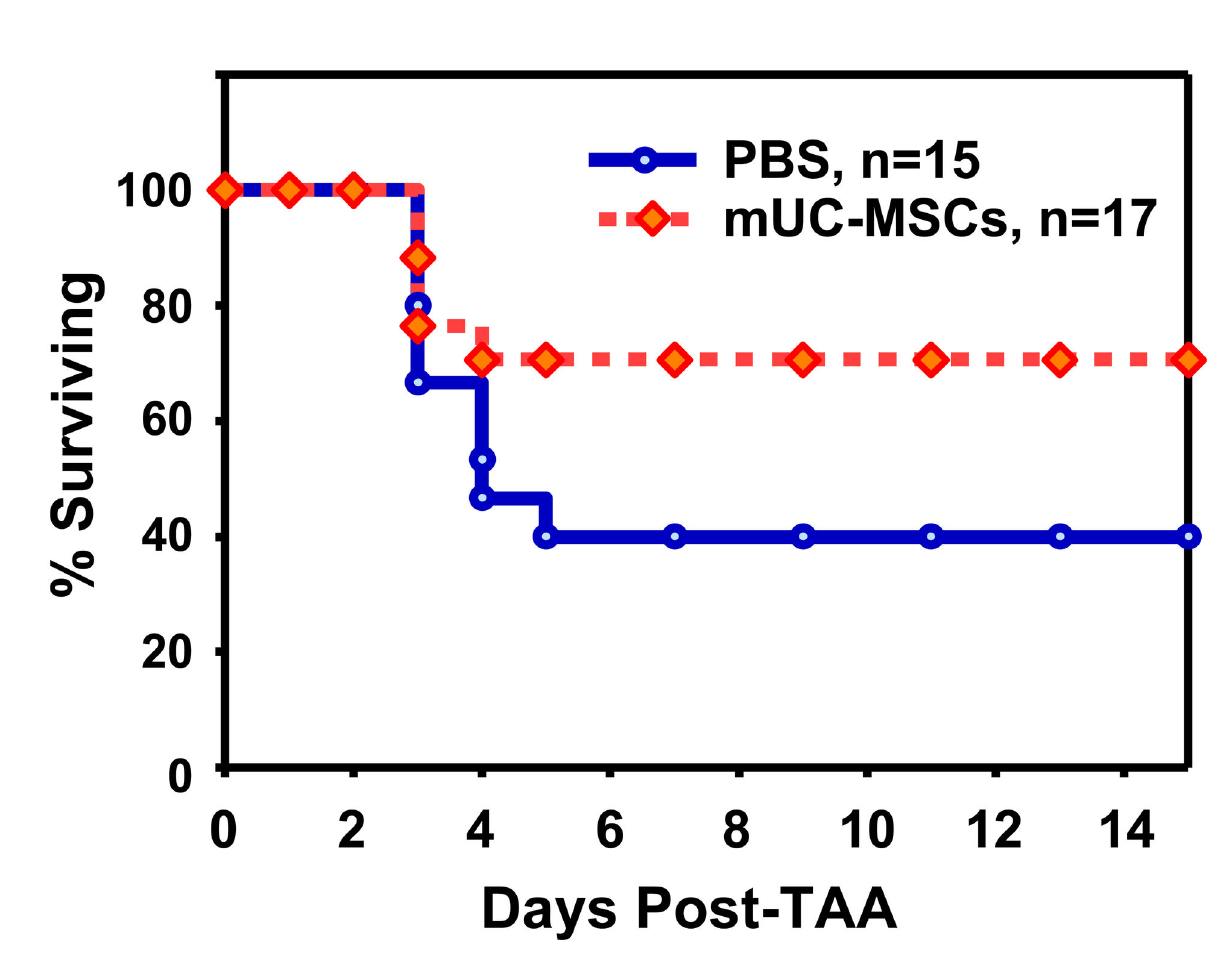
Figure 7. mUC-MSCs transplantation improves mice survival after TAA-induced acute hepatic failure. Male C57BL/6JNarl mice were administrated TAA (1000 mg/kg intraperitoneal injection) 6 hr prior to receiving 2 × 10 6 cells of mUC-MSCs (n = 17) or PBS control (n = 15) via tail vein injection, and the survival rate was analyzed. doi: Figure S1. OCT4 protein expressed in early passages of mUC-MSCs. mUC-MSCs were recognized by mesenchymal